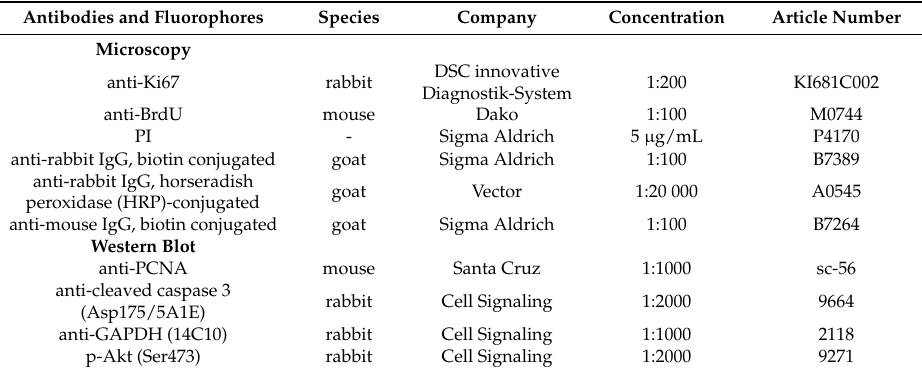
Table 1. Antibodies and